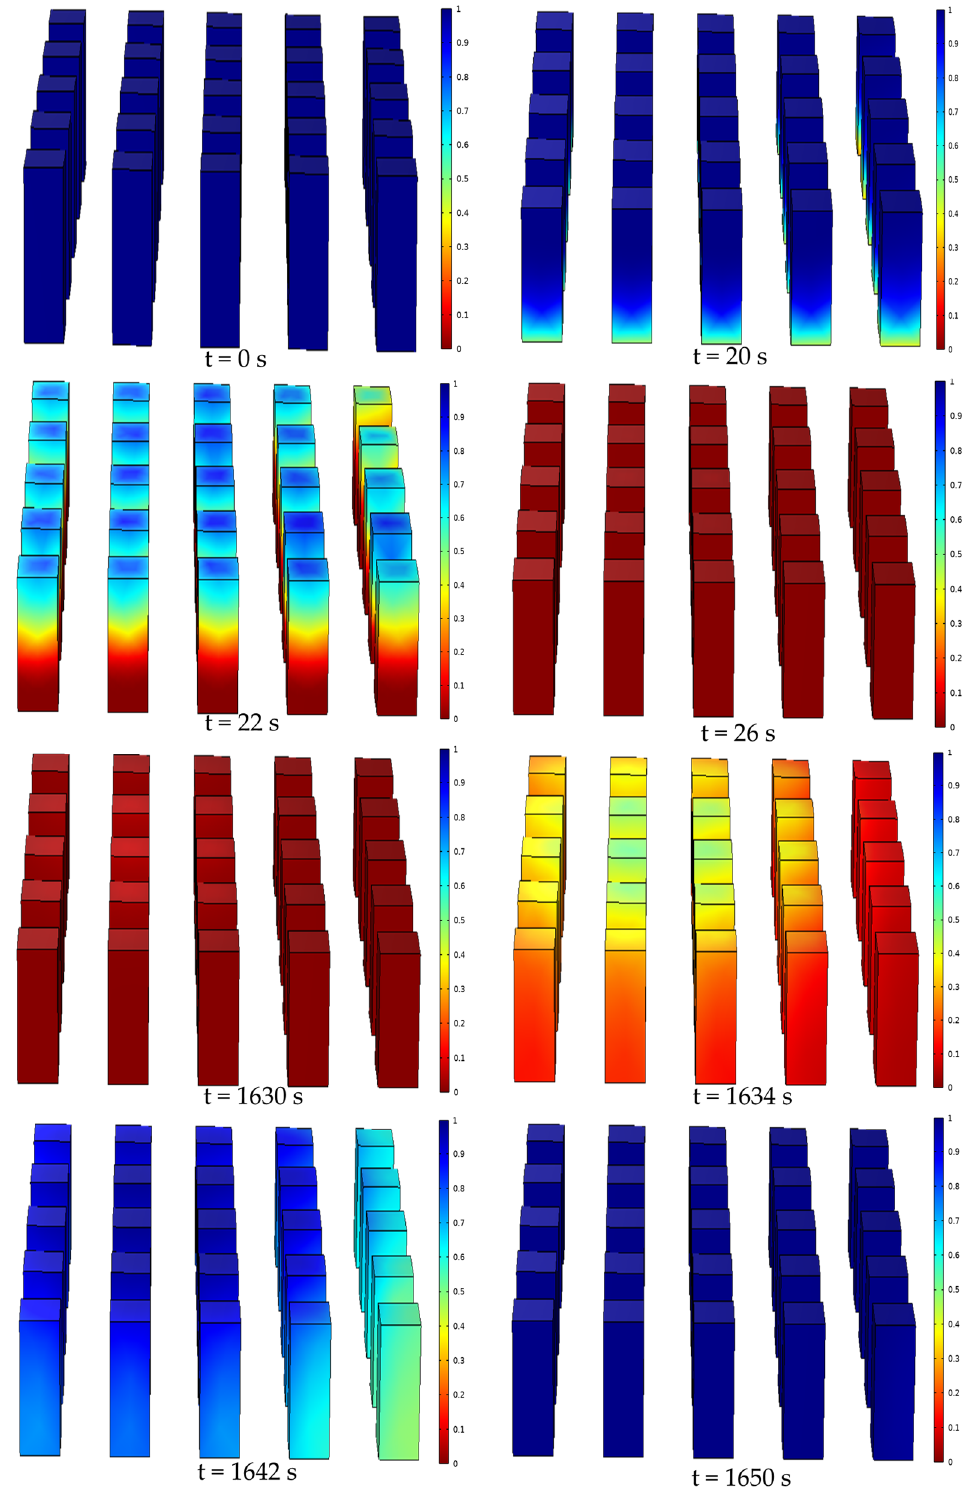
Figure 10. The phase transient profiles between and solid phases of the